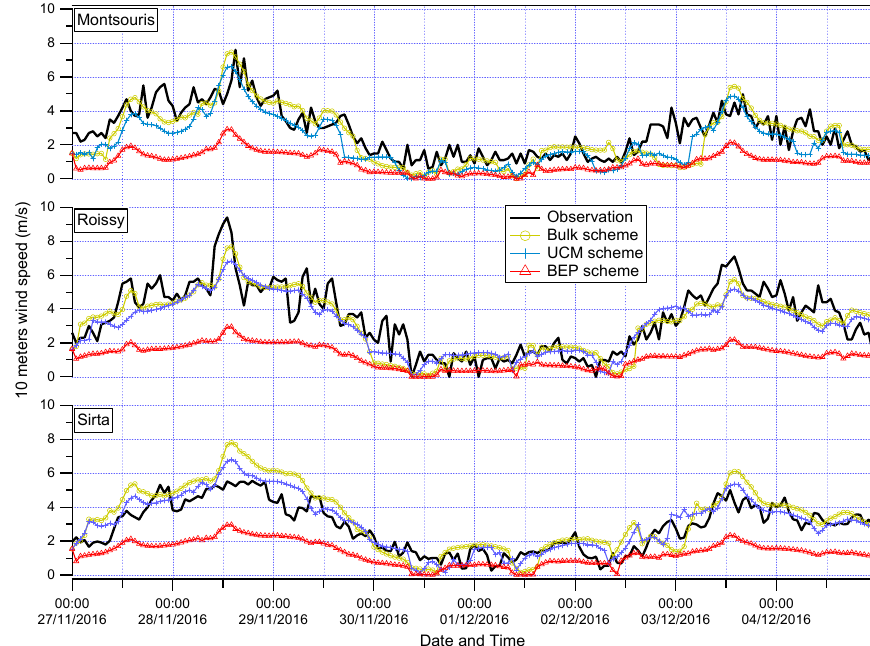
Figure 9. Comparison of the time series of 10 m wind speed ( m s − 1 ) between the observations and different urban schemes at Montsouris, Roissy and Sirta stations.